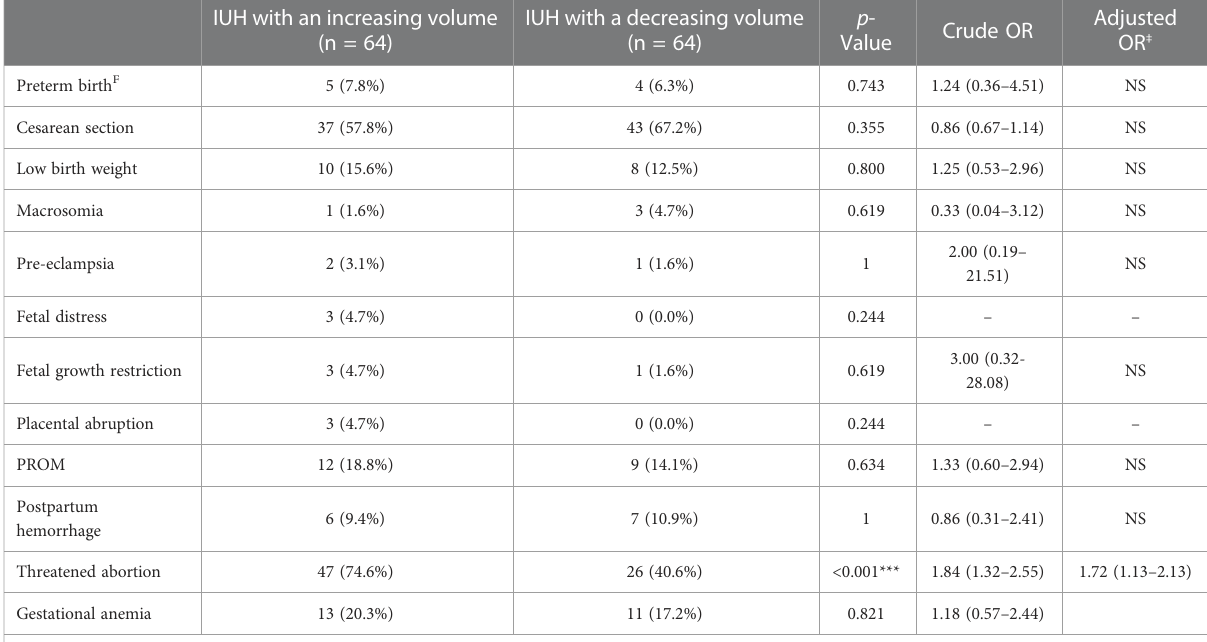
TABLE 3 Incidence and risks of pregnancy complications in IUH pregnancies with an increasing or decreasing volume of